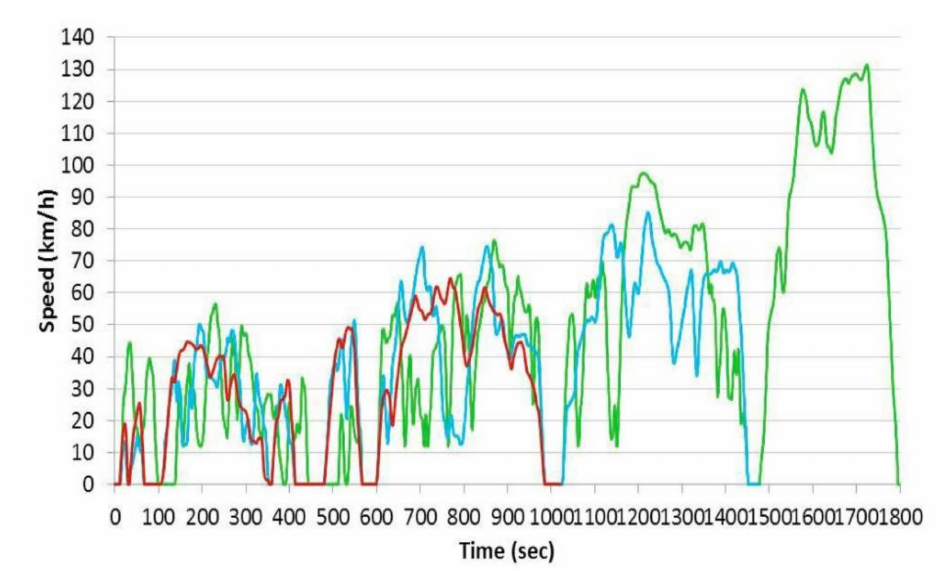
Figure 3. WLTC Driving Cycle with urban section in red, extra-urban section in green and combined driving in light blue. Reprinted with permission from original publication: “What is the Most Representative Standard Driving Cycle to Estimate Diesel Emissions of a Light Commercial Vehicle?”, by Daniel Chindamo and Marco Gadola. IFAC-PapersOnLine, 51-5, pp. 73–78 (2018) [23] @2018 International Federa-tion of Automatic Control